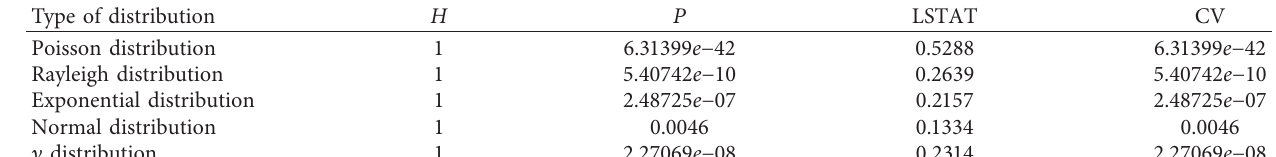
Table 4: The fitting results of different distribution